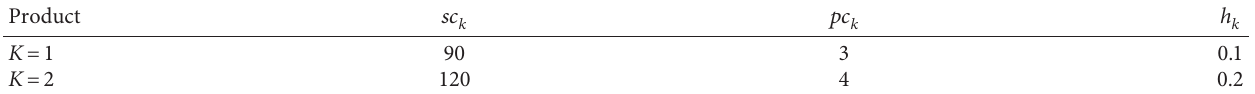
Table 1: The related costs of products.